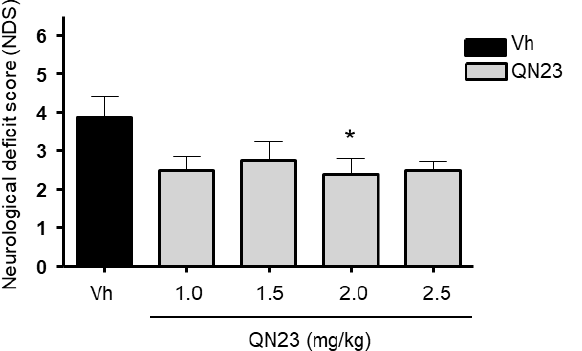
Figure 2. Neurodeficit score outcomes after cerebral ischemia in the dose–response study of QN23. Bar graph representation of the neurological deficit score (NDS) in ischemic animals at 5 days of reperfusion after ischemia. Animals were treated with vehicle (Vh) or QN23 in 1.0, 1.5, 2.0, or 2.5 mg/kg by an intravenous injection at reperfusion onset after cerebral ischemia. A total of 6–9 independent animals (as described in Figure 1) were averaged per group; error bars indicate the SE, * p < 0.05, compared with vehicle by Dunn’s post-test after the non-parametric Kruskal–Wallis